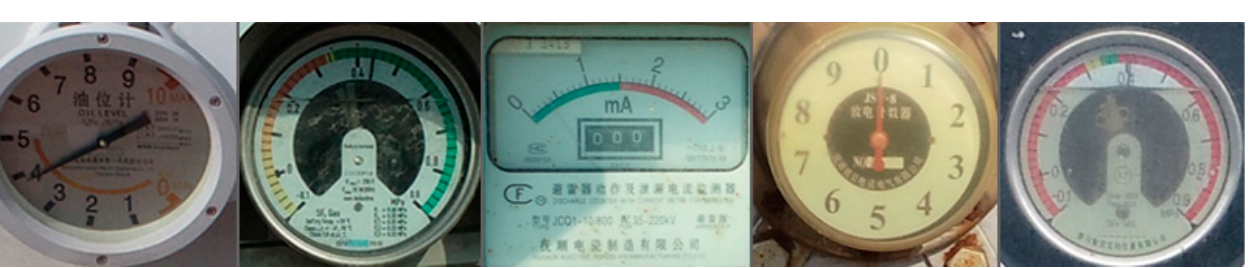
Figure 10. Meter images. Figure 10. Meter